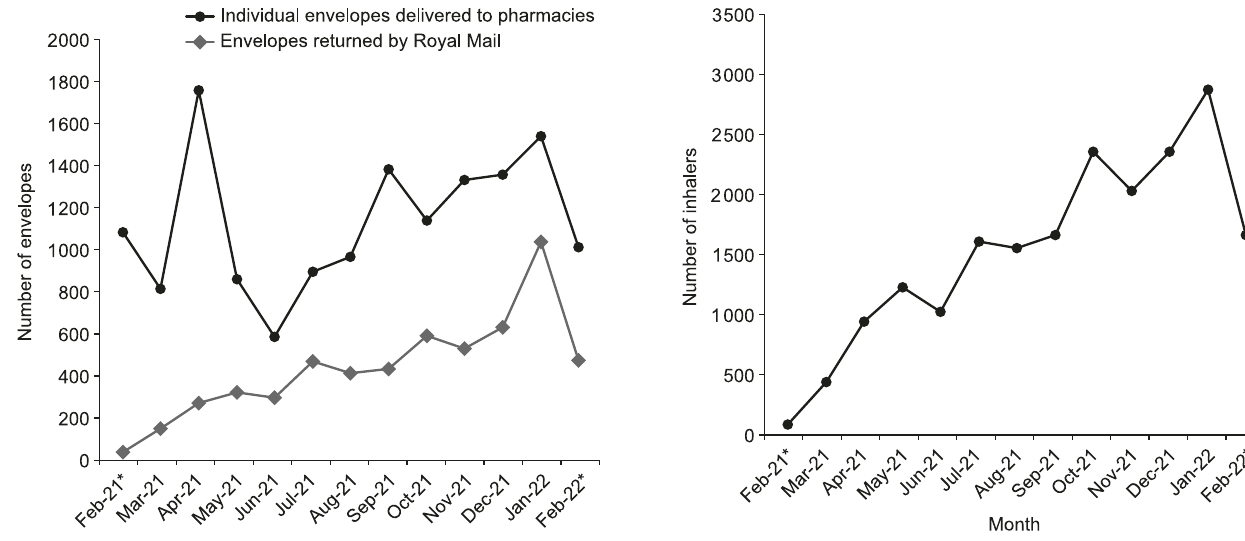
Fig. 4 Inhalers returned to waste management in each month. *February 2021 and February 2022 data include only 2 weeks of the